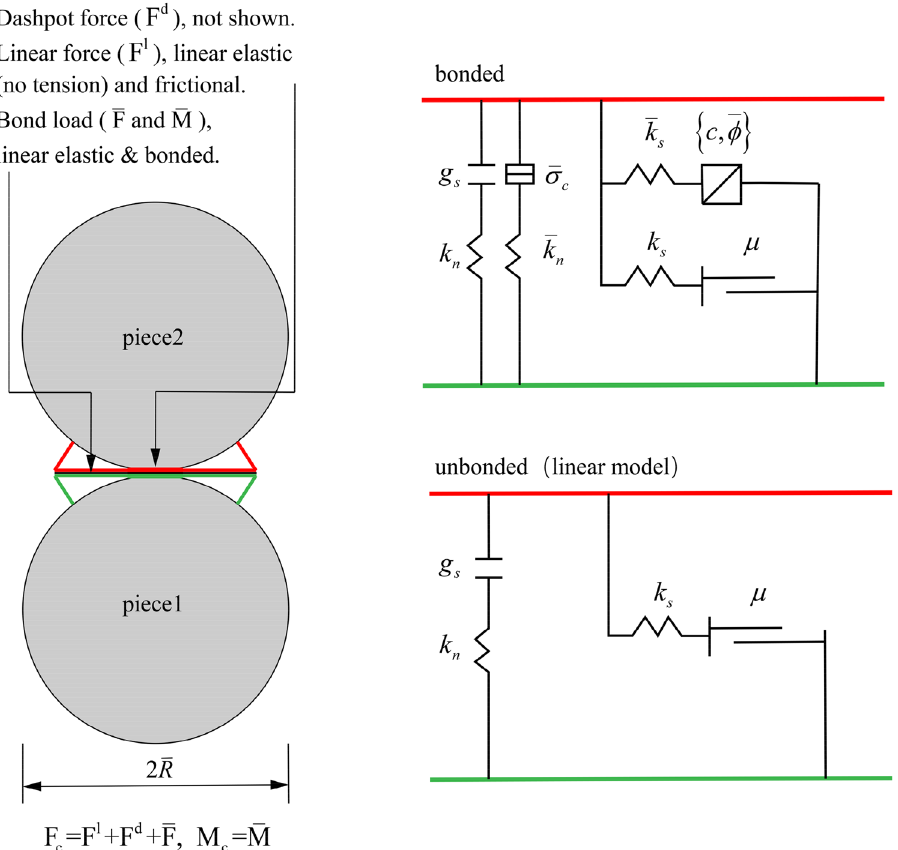
Figure 1. Behavior and rheological components of parallel bond model 35 .